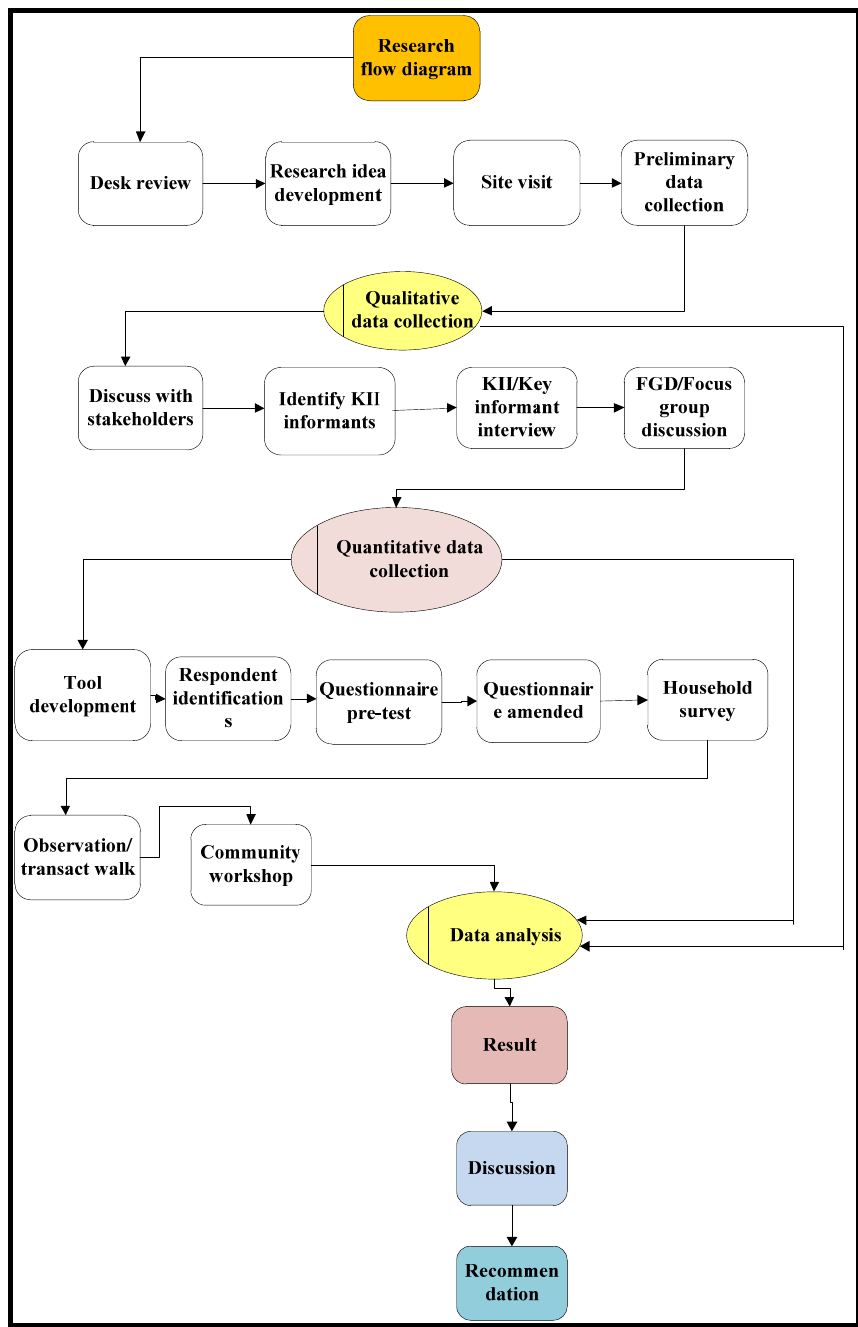
Figure 2. Research flow diagram.